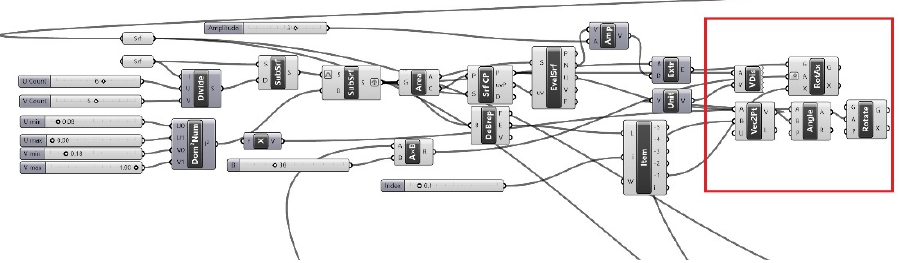
Figure 7. Louver Rotation Algorithm.